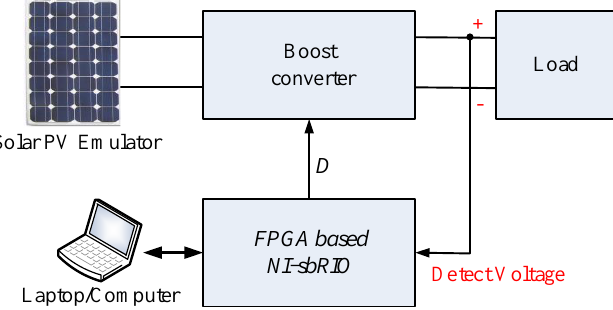
Figure 9. Block diagram of hardware scheme.